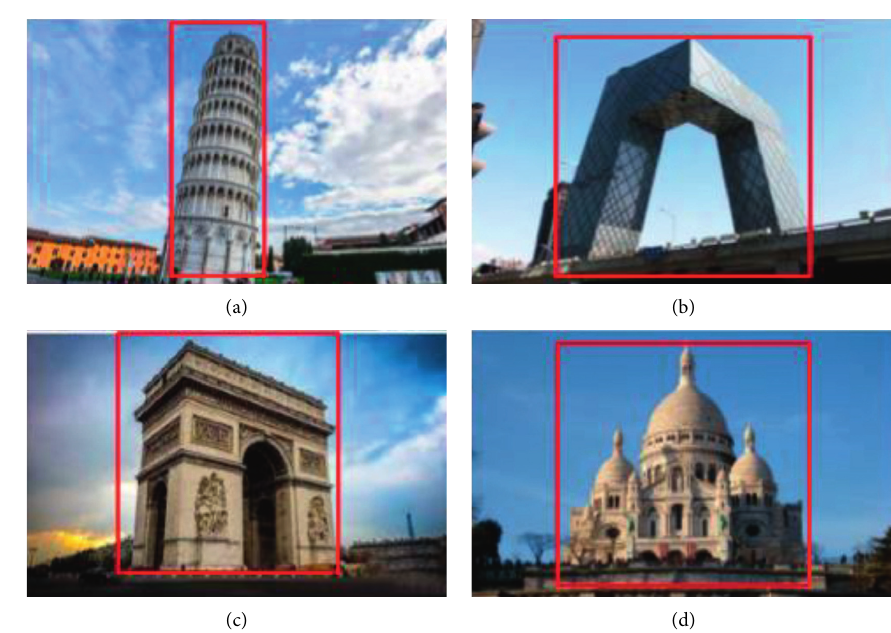
Figure 11: Screenshots of the results of detection and tracking of some